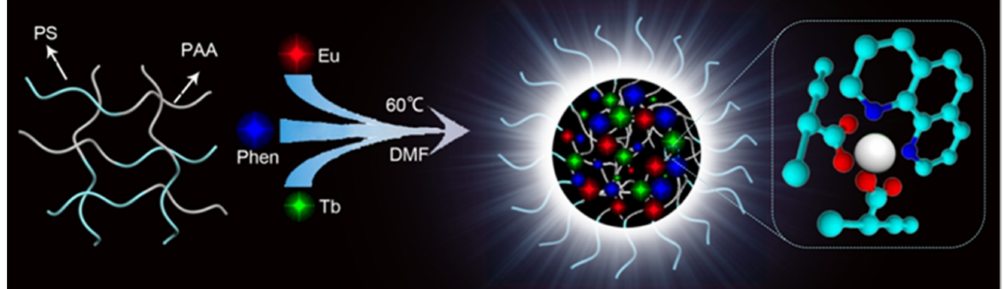
Figure 1. Schematic diagram of BCPs-Ln 3+ -Phen. BCPs, diblock